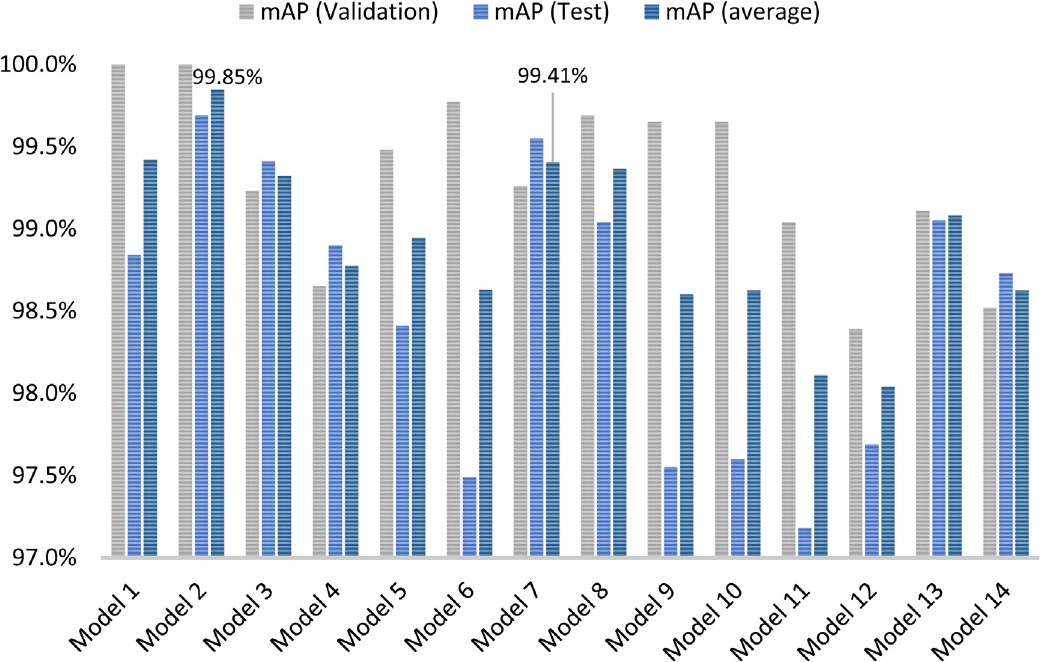
Fig. 5. The mAP values calculated from each model when performing single-class detection